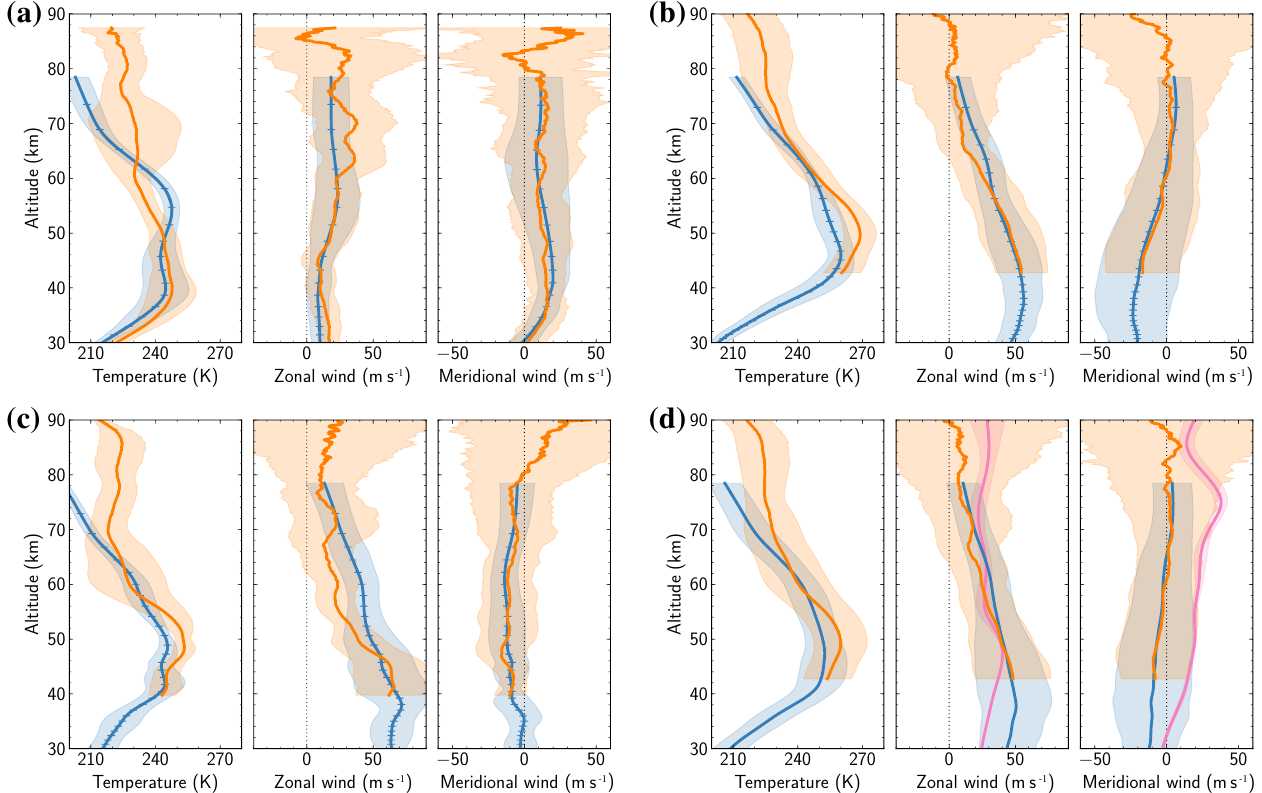
Figure 3. January mean temperatures and horizontal winds for the years 2012 (a) , 2014 (b) , and 2015 (c) and cumulated data (d) . ALOMAR RMR lidar (orange); ECMWF (blue); HWM07 (rose). Shaded areas represent the corresponding SDs. The horizontal bars mark the model levels of ECMWF data for one sample profile in each season. The ECMWF cycles used are Cy37r3 for 2012 and Cy40r1 for 2014 and 2015.